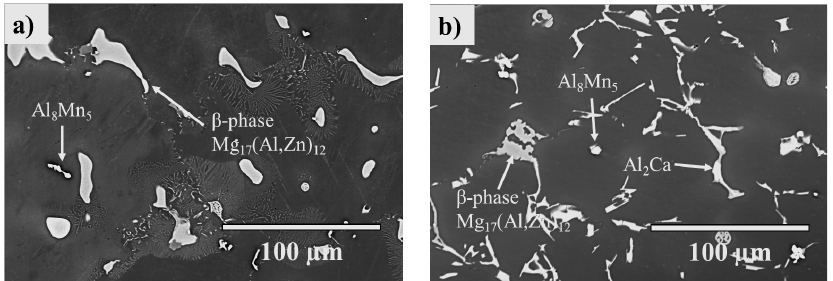
Figure 6. SEM micrographs of the ( a ) AZ91 and ( b ) AZ91– 2Ca alloys. Both alloys contain the β – Mg 17 (Al, Zn) 12 (bulk and lamellar) and Al 8 Mn 5 phases. The addition of Ca to AZ91 forms the Al 2 Ca phase.